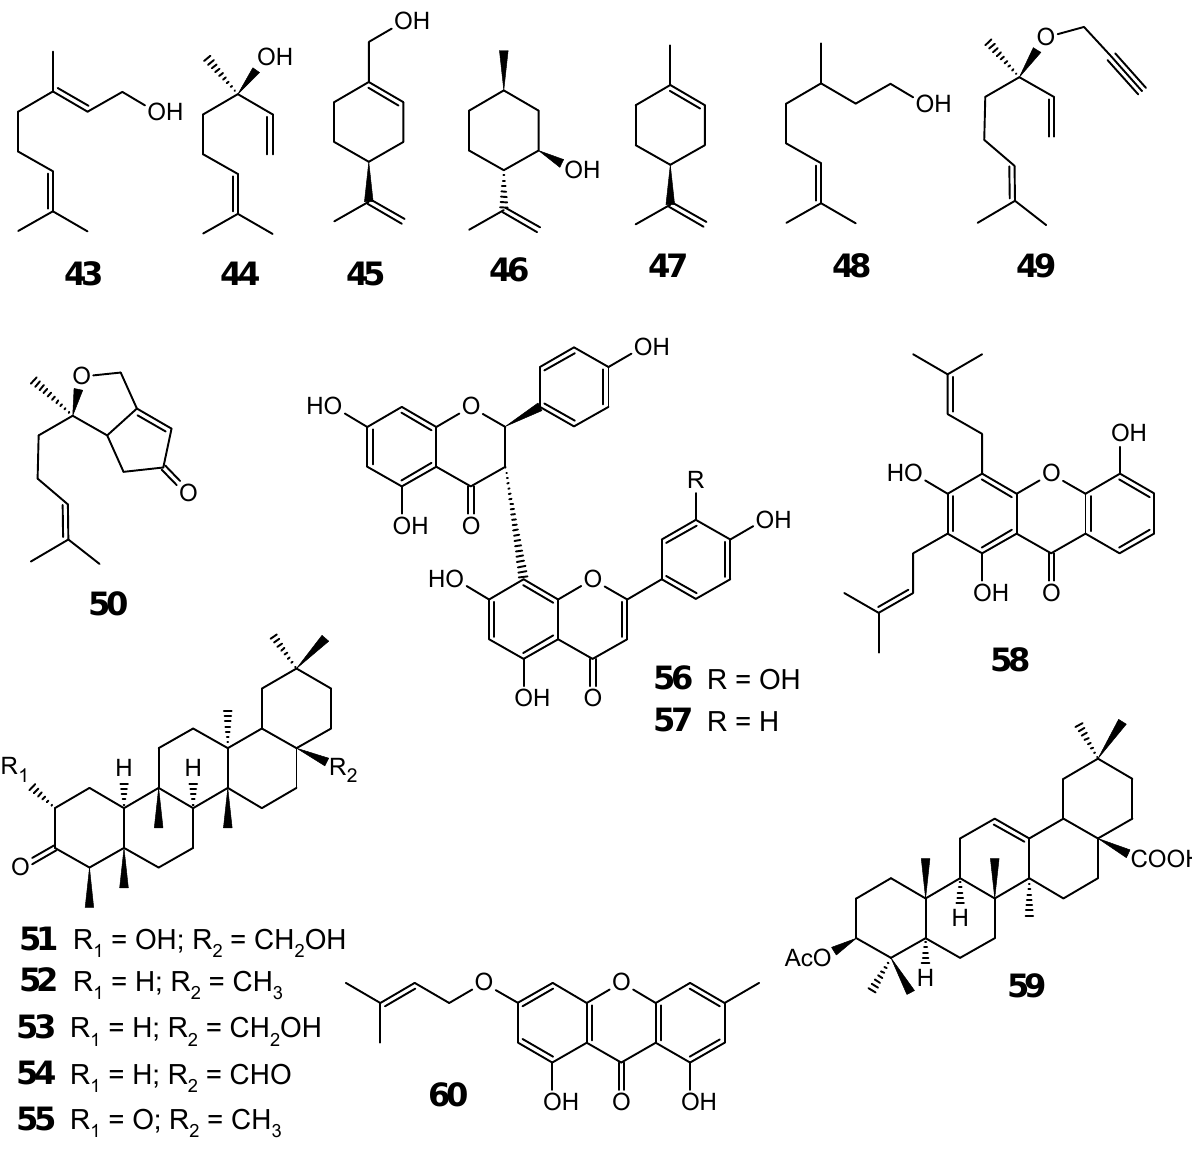
Figure 7. Antiplasmodial terpenes and related compounds 43-60